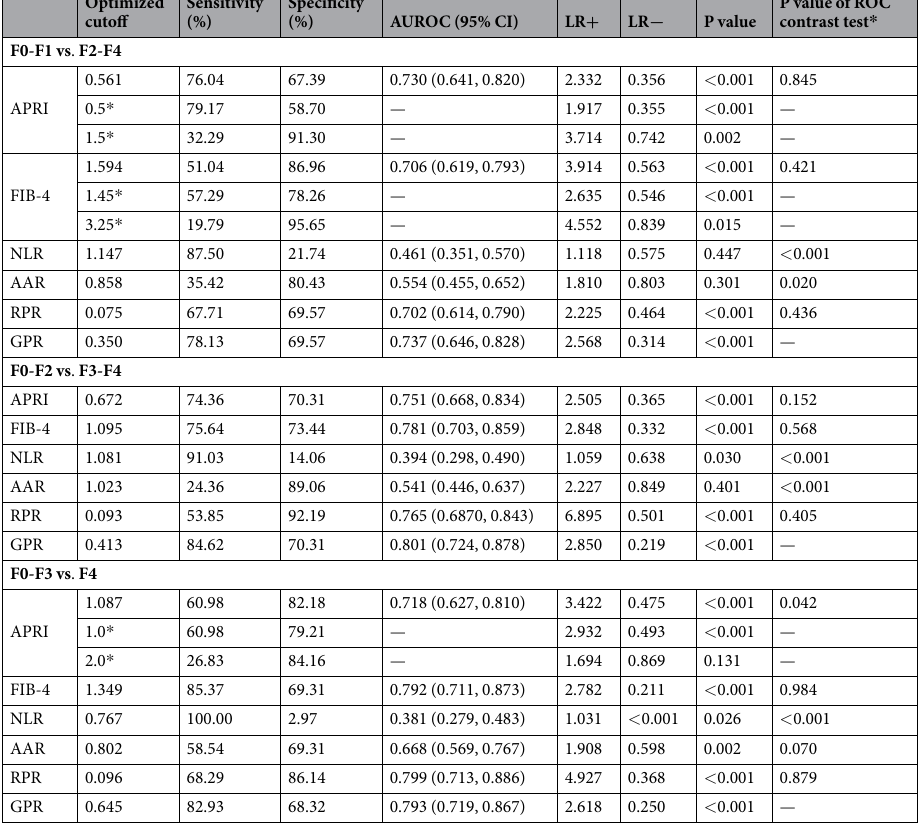
Table 3. Diagnostic accuracy of different indexes for the prediction of liver fibrosis in HBeAg positive CHB. * Compared with GPR. AUROC, area under the receiver operating characteristic curve; CI, confidence interval; LR − , negative likelihood ratio; LR + , positive likelihood ratio; AAR, aspartate aminotransferase/alanine aminotransferase ratio; APRI, aspartate aminotransferase-to-platelet ratio index; FIB-4, fibrosis index based on the four factors; GPR, gamma-glutamyl transpeptidase to platelet ratio; NLR, neutrophil-to-lymphocyte ratio; RPR, red cell distribution width-to-platelet ratio. * Threshold recommended by the WHO 12